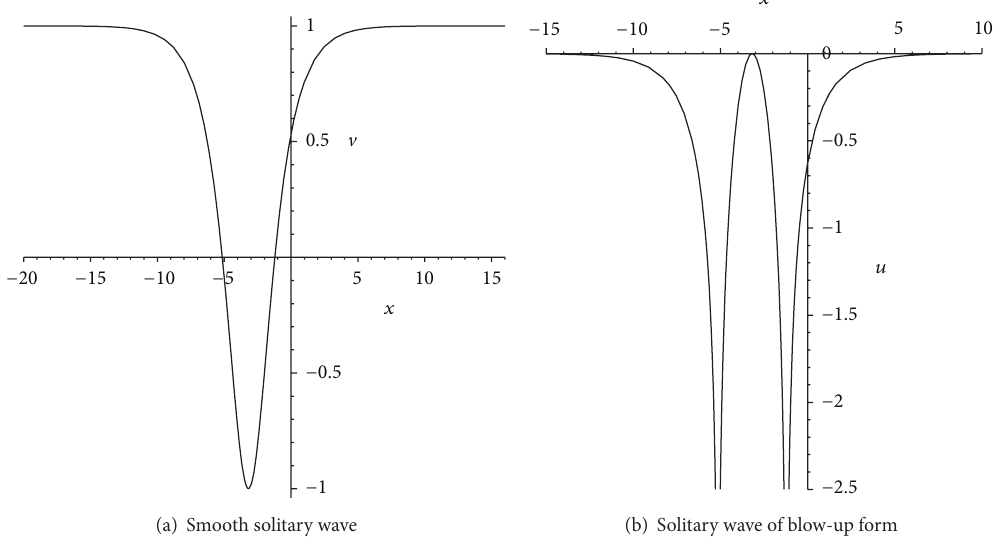
Figure 3: The phase portraits of solutions (64) and (65) for 𝑚 = 2 , 𝛼 = 0.3 , 𝛽 = −0.3 , 𝑐 = −2 , 𝑡 = 0.1 .